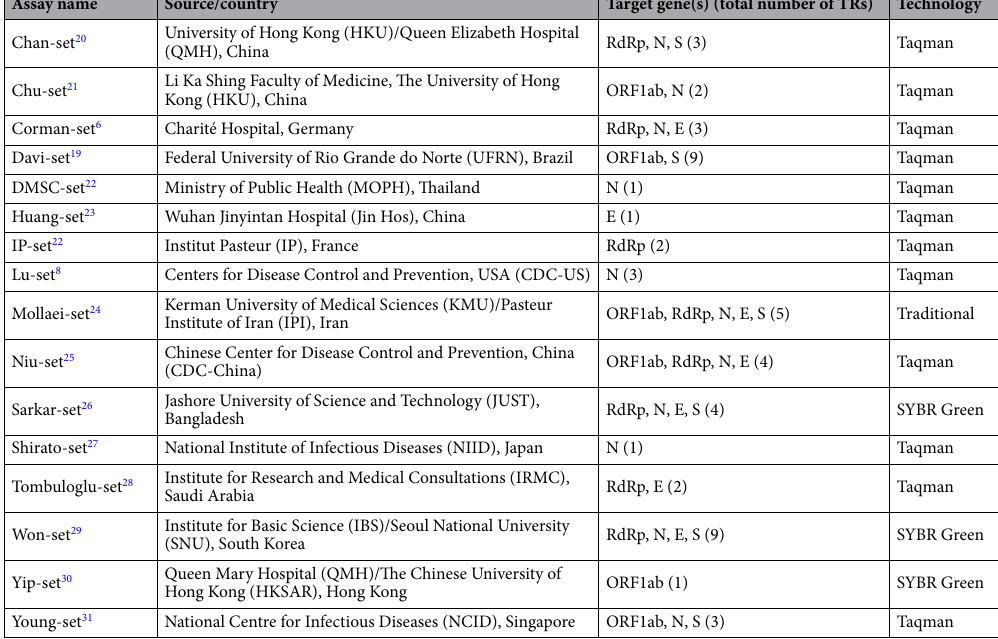
Table 1. SARS-CoV-2 PCR primer sets analyzed in this study. Primer set names are based on the first author’s last name of the